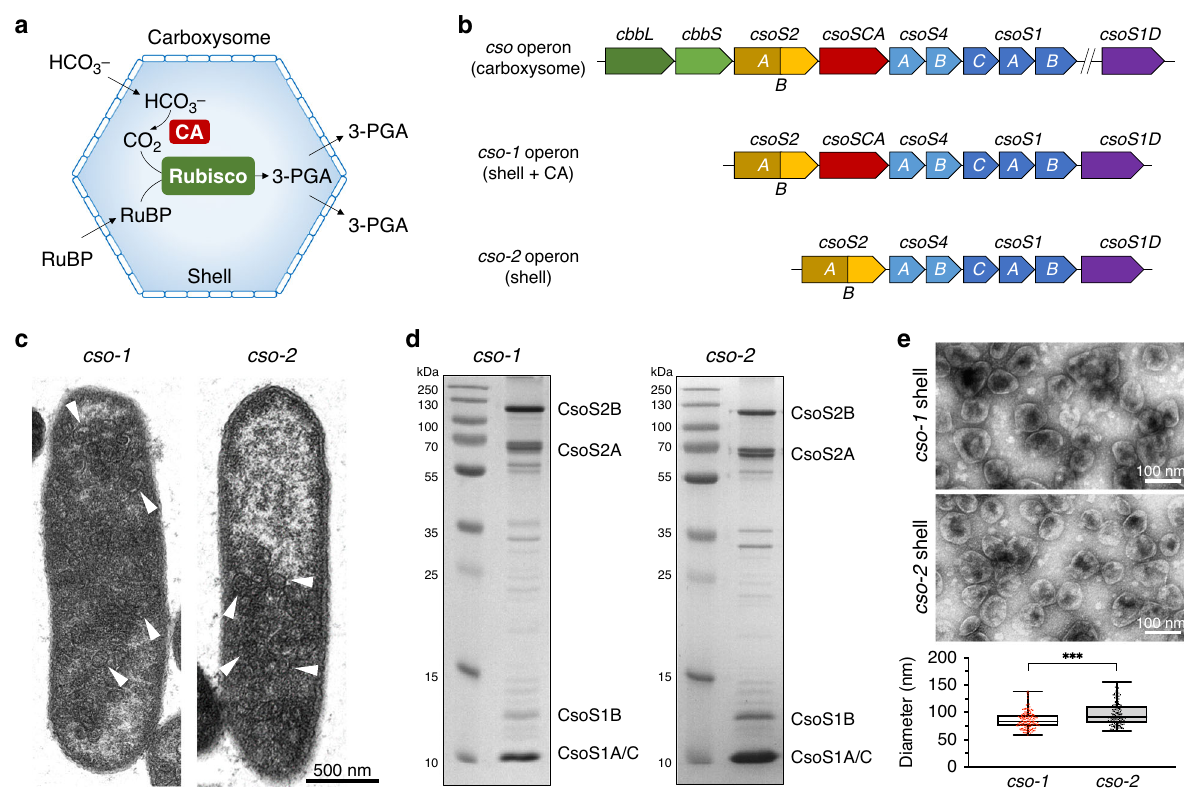
Fig. 1 Engineering and characterization of empty α -carboxysome shells. a Schematic of the carboxysome structure and metabolic pathways. The carboxysome shell serves as a physical barrier to permit passage of cytosolic bicarbonate (HCO 3 − ) and ribulose-1,5-bisphosphate (RuBP) into the carboxysome. The metabolic product 3-phosphoglycerate (3-PGA) is transported across the shell and is metabolized via the Calvin – Benson – Bassham cycle. b Genetic organizations of the native cso operon, synthetic cso-1 and cso-2 operons. c Thin-section electron microscopy (EM) of E. coli cells expressing the cso-1 operon (left) and cso-2 operon (right), respectively. Arrows indicate α -carboxysome shell particles discerned in the cell. d SDS-PAGE of puri fi ed cso-1 (left) and cso-2 (right) shell structures. e Transmission EM of puri fi ed cso-1 (top) and cso-2 (middle) shells in the 20% sucrose fractions. Shells with CA are signi fi cantly smaller in diameter than those without CA. *** p < 0.001 ( p = 0.0007, n = 150, two-tailed unpaired t -test), implying the role of CA in con fi ning shell architecture (bottom). Box and whisker plots indicate the median (middle line in the box), 25th percentile (bottom line of the box), 75th percentile (top line of the box), as well as the minima and maxima (whiskers). Source data underlying c – e are provided as a Source data fi